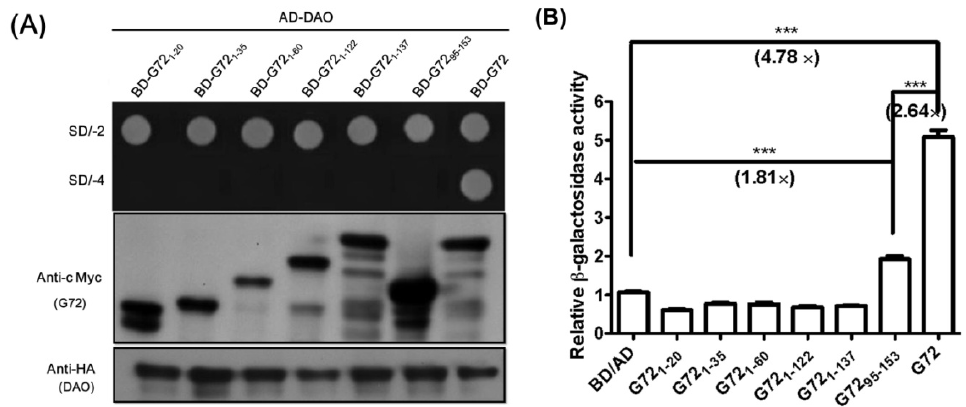
Figure 3. The C -terminal region of G72 interacts with DAO. ( A ) Upper panel. Only yeast co-transformed with plasmids containing the genes for AD-DAO and BD-G72 were viable on SD/-2 and SD/-4 plates. Yeast co-transformed with AD-DAO and a truncated form of the BD-G72 gene was not viable on SD/-4 plates. Lower panel. Western blotting to confirm that AD-DAO and BD-G72 and truncated forms of BD-G72 were expressed in the yeast system; and ( B ) The relative strengths of the interactions between DAO and G72 or a truncated form of G72 were determined by the level of β -galactosidase activity and normalized to the activity in yeast co-transformed with the AD and BD tags. *** p <